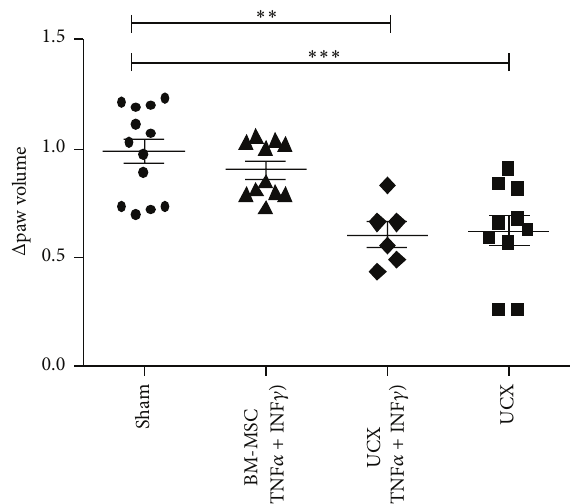
Figure 4: Effect of UCX in an acute inflammation model. Wistar rats (7 to 8 weeks old) were treated either with PBS vehicle (sham control), BM-MSCs (1.7 × 10 6 cells), UCX (1.7 × 10 6 cells), or UCX previously activated with 10ng/mL of TNF 𝛼 and IFN 𝛾 (1.7 × 10 6 cells), 1 hour prior to challenge with 𝜆 -carrageenan in the right paw. Anti-inflammatory effect in vivo was assessed by measuring the paw volume at maximum peak time – 6 h, relative to the preinjection volume. Data is presented as mean ± s.e.m. and statistically significant differences are indicated by asterisks (nonparametric test Mann Whitney; ∗ 𝑃 < 0.05 , ∗∗ 𝑃 < 0.01 , and ∗∗∗ 𝑃 < 0.001